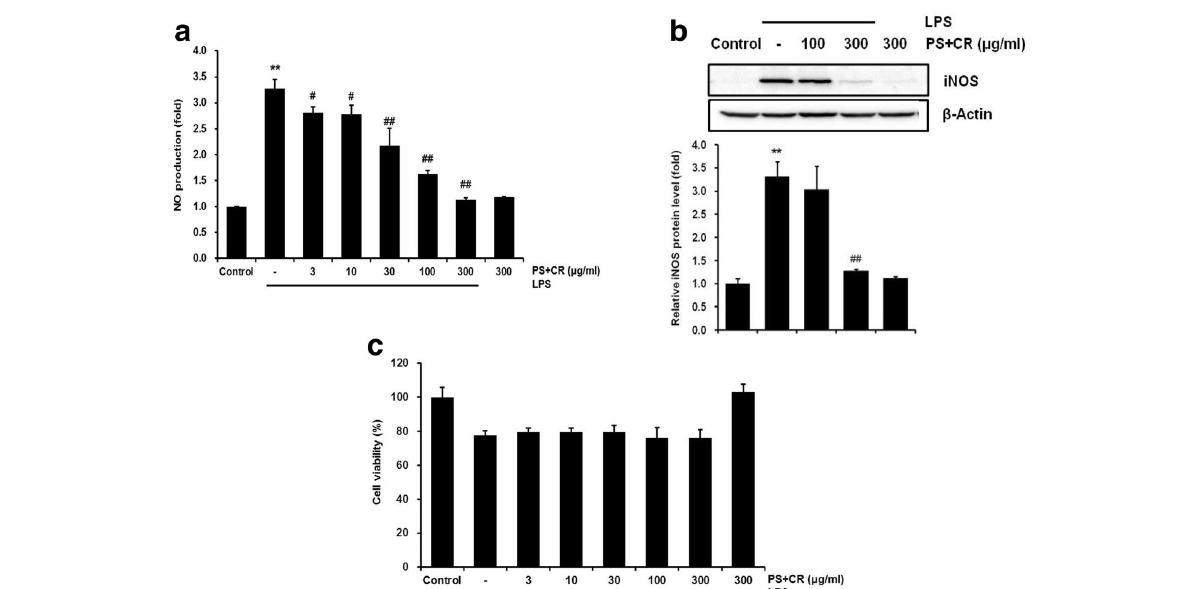
Fig. 2 Inhibition of nitric oxide (NO) production and inducible nitric oxide synthase (iNOS) expression by PS + CR. RAW 264.7 cells were treated with 3 – 300 μ g/ml PS + CR for 1 h prior to the addition of lipopolysaccharide (LPS) (1 μ g/ml) and further incubated for 24 h. a Effects of PS + CR on NO production. Secreted nitrite concentrations in the culture medium were assayed using the Griess reagent method. b Effects of PS + CR on iNOS protein expression. Equal amounts of total protein (50 μ g) were separated by SDS-PAGE. β -Actin was used as a loading control, and the bar chart shows the quantitative evaluation of iNOS bands by densitometry. (c) Effects of PS + CR plus LPS on cell viability. Cell viability was measured